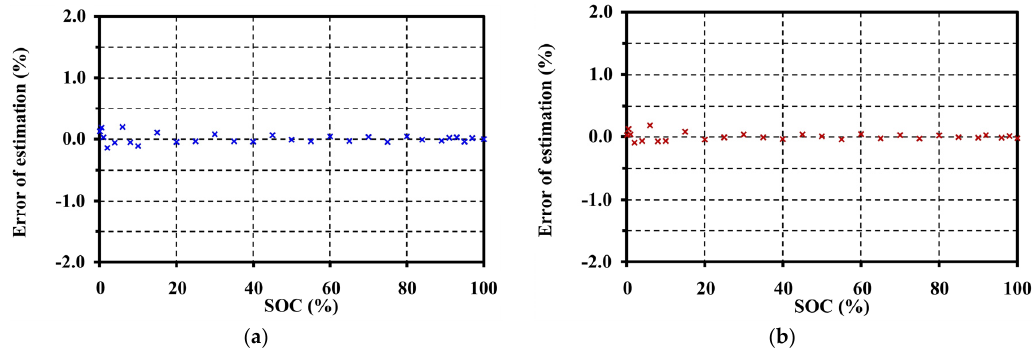
Figure 16. Error evaluation for the OCV model validation for the LMO at 20 °C: ( a ) error of estimation for charge; and ( b ) error of estimation for discharge.